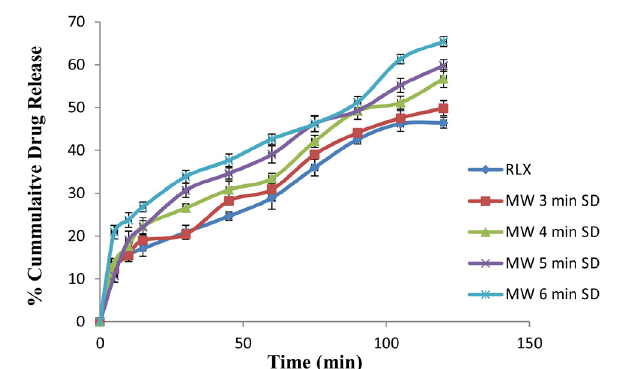
FIGURE 2 - Dissolution profiles of raloxifene HCl and solid dispersions prepared by the microwave induced fusion method. RLX, Raloxifene HCl. Solid dispersions (SD) were prepared by the microwave (MW) induced fusion method with different exposure times (3, 4, 5 and 6